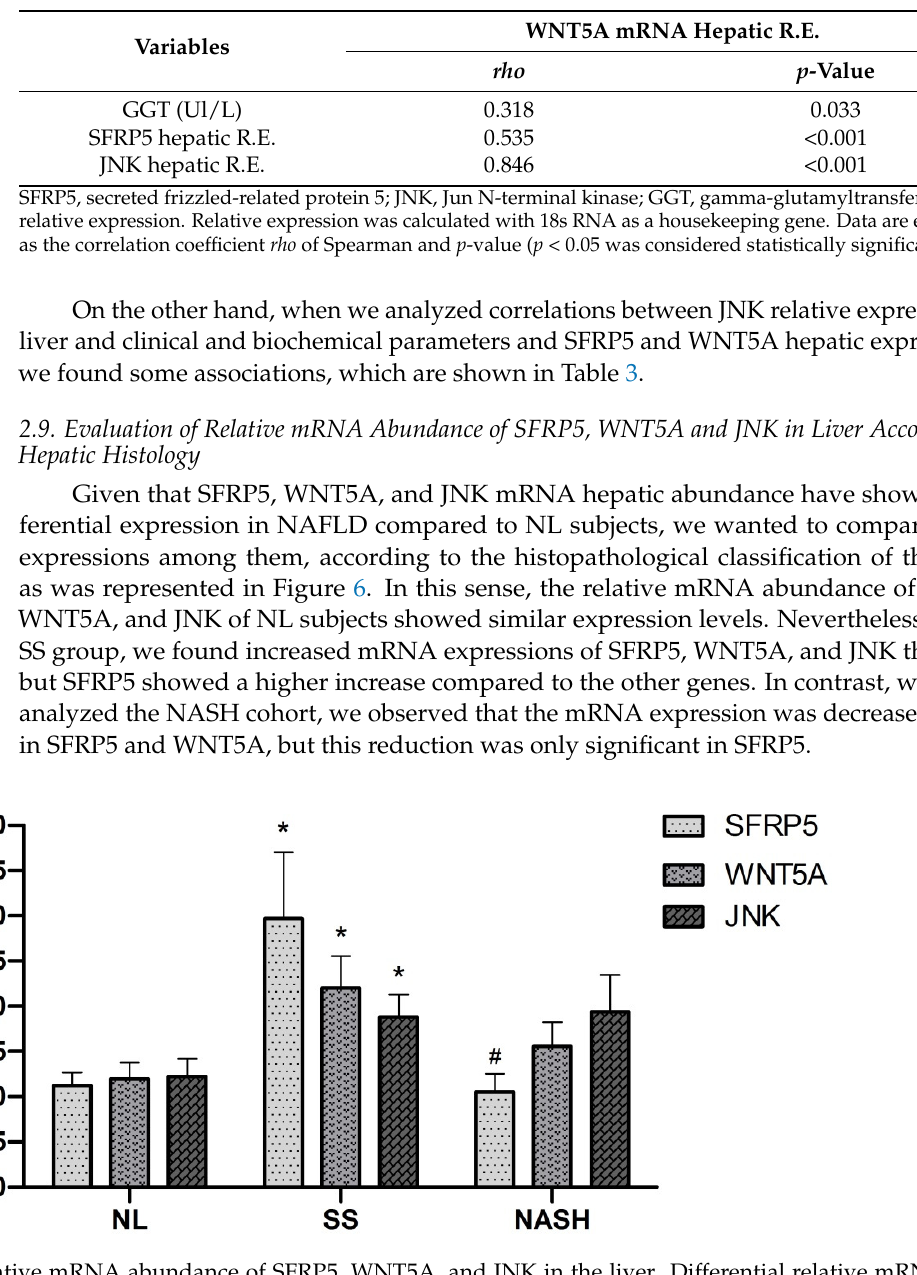
Figure 6. Differential relative mRNA abundance of SFRP5, WNT5A, and JNK in the liver. Differential relative mRNA abundance of SFRP5, WNT5A, and JNK in the liver of women with MO subclassified by NL, SS, and NASH. MO, morbid obesity; NL, normal liver; SS, simple steatosis; NASH, nonalcoholic steatohepatitis; SFRP5, secreted frizzled-related protein 5; WNT5A, WNT family member 5a; JNK, Jun N-terminal kinase; A.U, arbitrary units. * Significant differences between the NL group and the SS group ( p < 0.05). # Significant differences between SS group and NASH group ( p < 0.05).